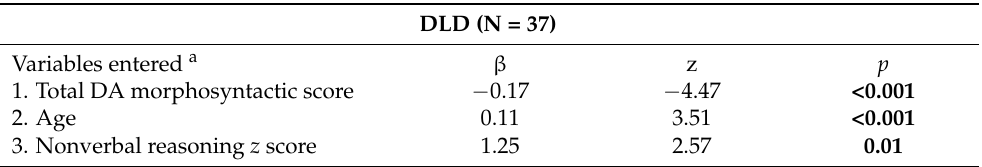
Table 6. Stepwise logistic regression: DLD diagnosis (dependent variable), and Total DA morphosyn- tactic score, nonverbal reasoning z score, and age (independent